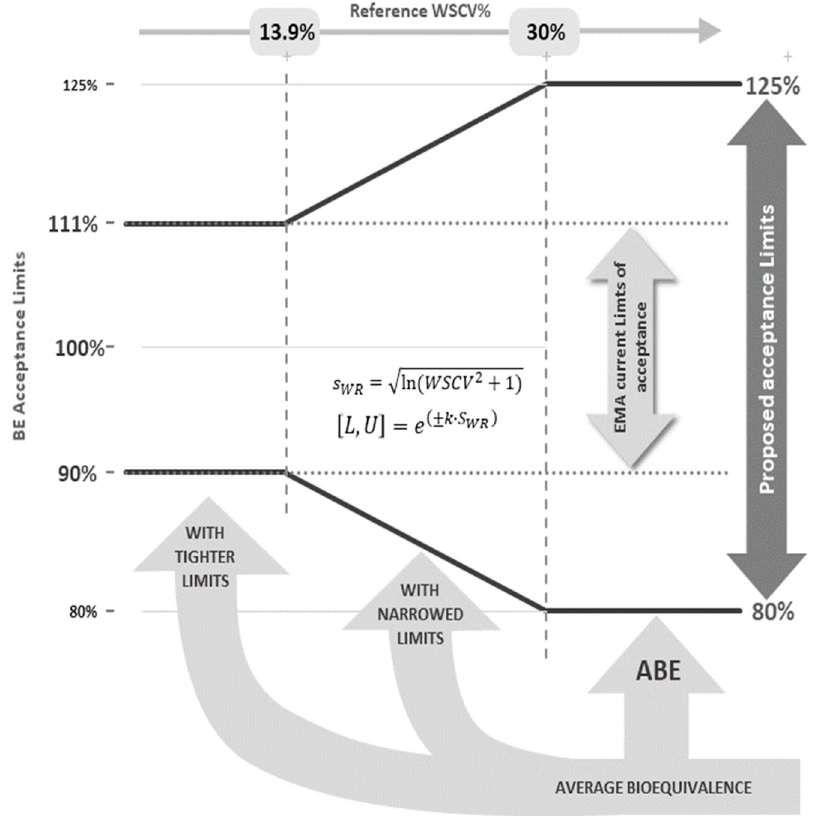
Figure 1. Acceptance limits for the 90% CI of the test-to-reference GMR of NTI drugs according to the WSCV of the reference product.